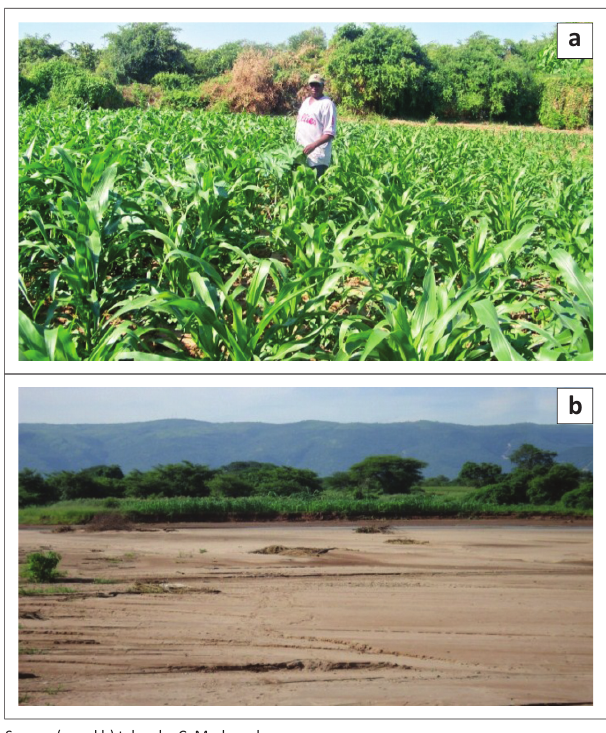
FIGURE 4: (a, b) Mudzedze (maize crop) thriving along the silted river.